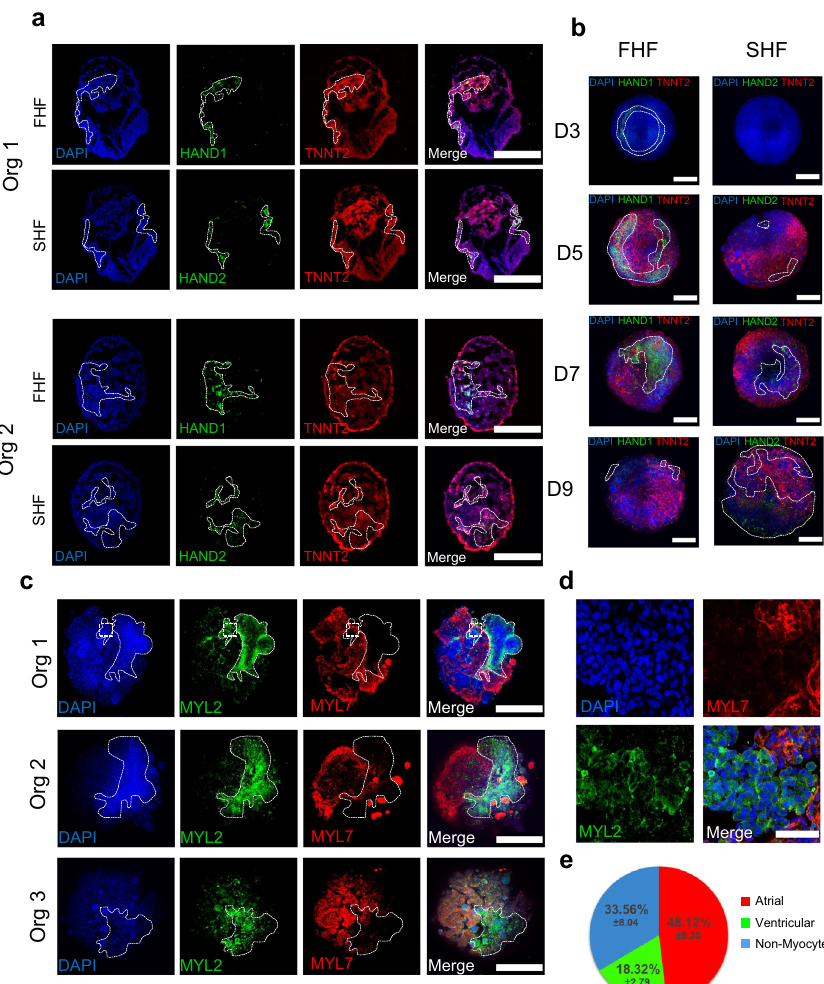
Fig. 4 Heart fi eld development and cardiomyocyte speci fi cation in human heart organoids. a Confocal immuno fl uorescent images of two representative hHO cryosections on day 8 of differentiation showing robust HAND1 (FHF) and HAND2 (SHF) transcription factor expression (green) in different sections of the same organoid; TNNT2 (red), DAPI (blue); scale bar: 500 µ m, ( n = 12 organoids). b Day 3 to day 9 hHOs showing formation of FHF (HAND1, left) and SHF (HAND2, right); scale bar: 500 µ m. c Confocal immuno fl uorescence images of three representative day 15 hHOs containing well-differentiated ventricular (MYL2, green) and atrial (MYL7, red) regions, DAPI (blue); scale bar: 500 µ m ( n = 10). d Inset images of organoid 1 from ( c ) scale bar: 50 µ m. e Pie chart showing the percentage of atrial cardiomyocytes (MLC2a + DAPI), ventricular cardiomyocytes (MLC2v + DAPI), and non-myocyte cells (DAPI only); value = mean ± SD, ( n = 6 organoids). FHF: fi rst heart fi eld, Org: organoid, SHF: second heart fi eld. Source data are provided as a Source Data fi